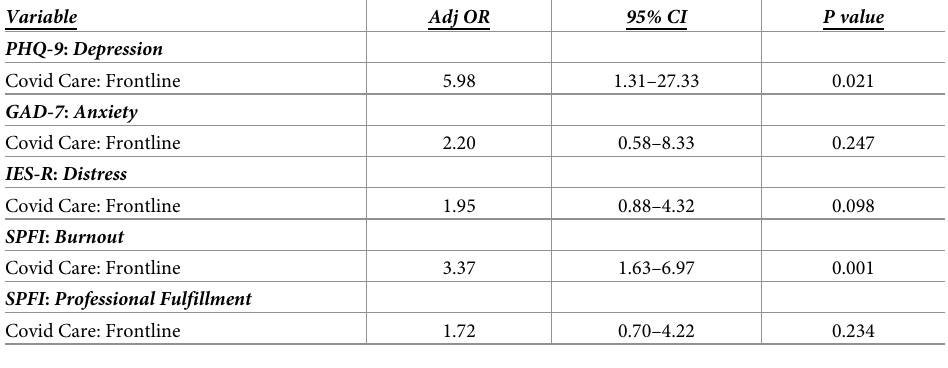
Table 3. Multivariate logistic regression